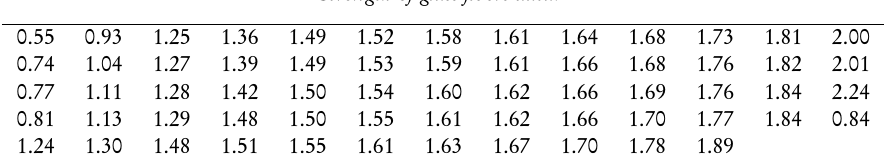
Strength of glass fibers data.